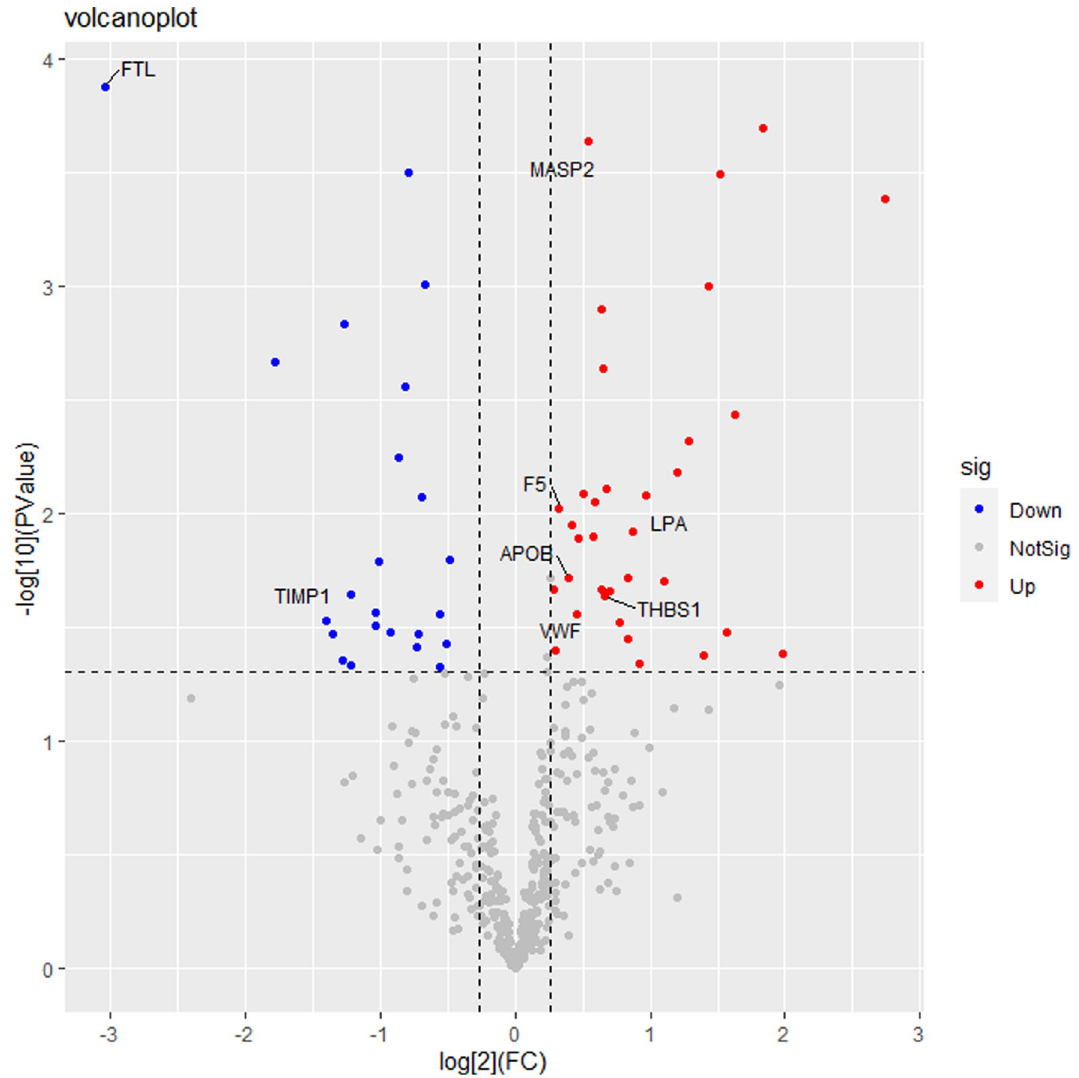
Figure 3. Volcano figure. The main differential proteins are marked in the figure. Blue dots on the plot represent down-regulated proteins, red dots represent up-regulated proteins, and gray dots represent proteins that are not significantly differentially